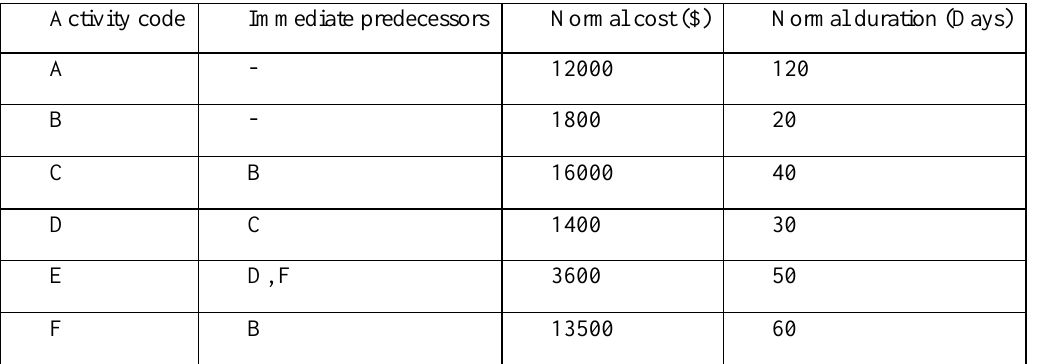
Table 1. Construction project data.